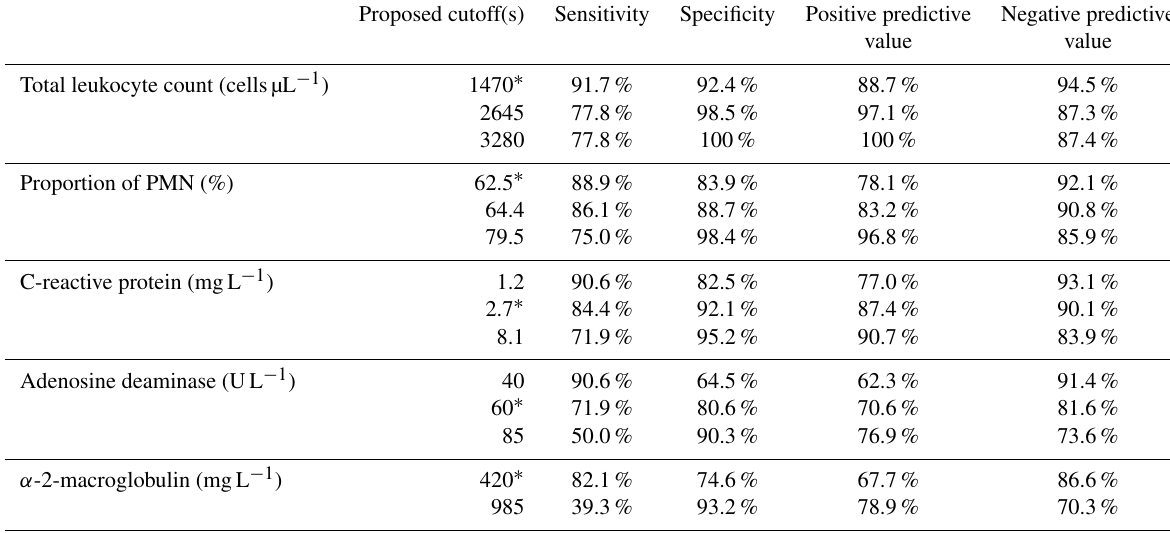
Table 3. Statistically optimal and selected rule-in and rule-out cutoff diagnostic performance. Proposed